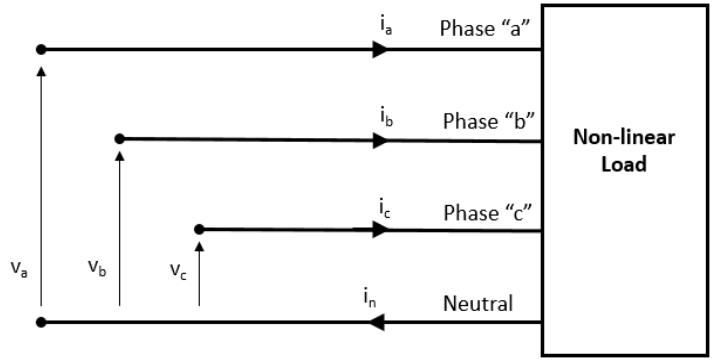
Figure 1. Three-phase electrical system with non-linear load.